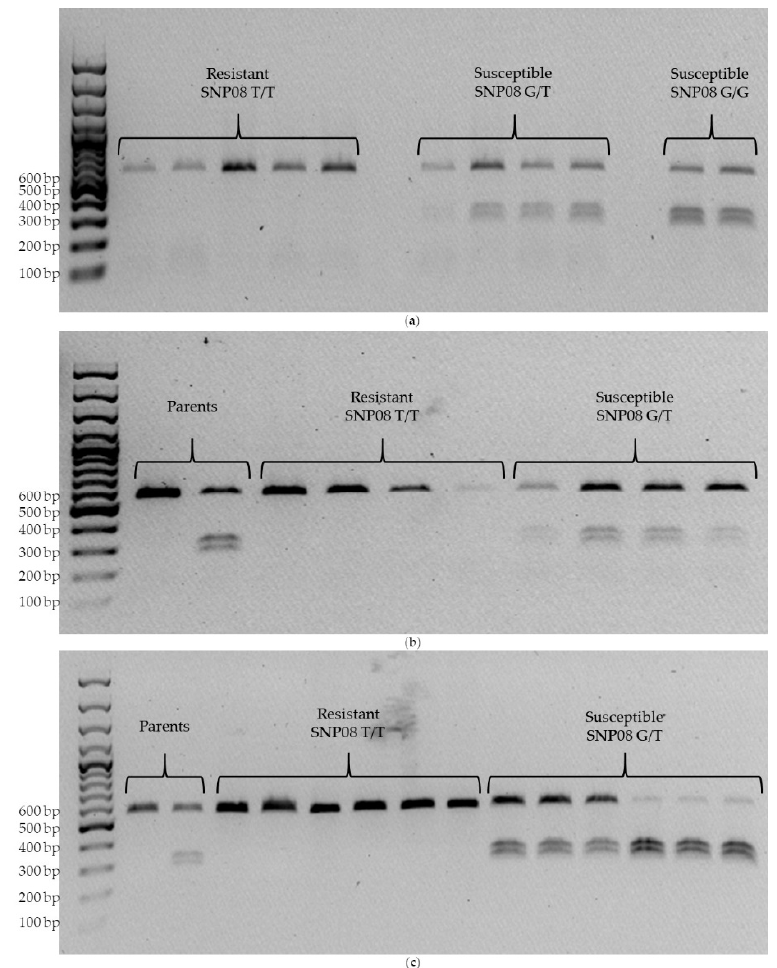
Figure 8. Digestion with BccI enzyme. ( a ) Profile of resistant and susceptible accessions of the CREA germplasm. In order: lane 1, 100 bp marker (GeneRuler DNA Ladders, ThermoFisher); lane 2, Afourer (Profile 1C in HRM); lane 3 and 4, ISA and Foma107 (Profile 1A in HRM); lane 5 and 6, Cami and King (Profile 1B in HRM); lane 8 and 9, Seedless Kishu and Fortune (Profile 2A in HRM); lane 10 and 11, Murcott and Ponkan (Profile 2B in HRM); lane 13 and 14, Dancy and Minneola (Profile 3A in HRM). ( b ) Profile of resistant and susceptible hybrids of Rubino × Murcott. In order: lane 1, 100 bp marker (GeneRuler DNA Ladders, ThermoFisher); lane 2, Rubino; lane 3, Murcott, lane 4 to lane 7, resistant hybrids; lane 8 to 11, susceptible hybrids. ( c ) Profile of resistant and susceptible hybrids of Cami × Seedless Kishu. In order: lane 1, 100 bp marker (GeneRuler DNA Ladders, ThermoFisher); lane 2, Cami; lane 3, Seedless Kishu, lane 4 to lane 9, resistant hybrids; lane 10 to 15, susceptible hybrids.